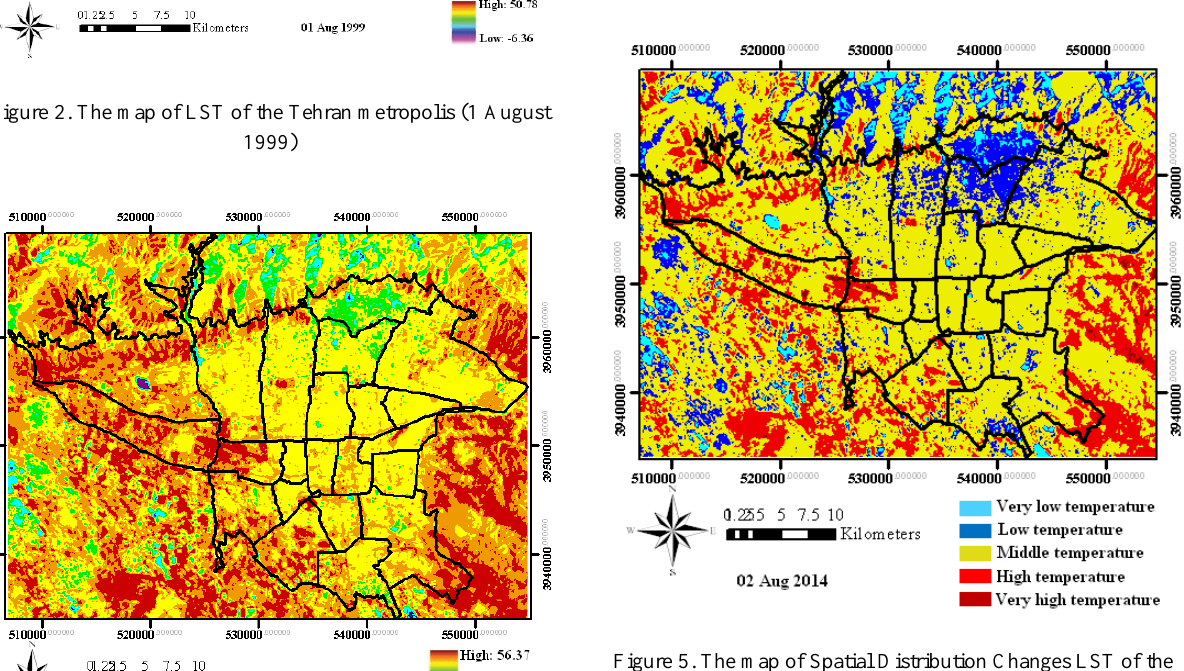
Figure 5. The map of Spatial Distribution Changes LST of the Tehran metropolis (02 August Figure 3. The map of LST of the Tehran metropolis (02 August 2014)